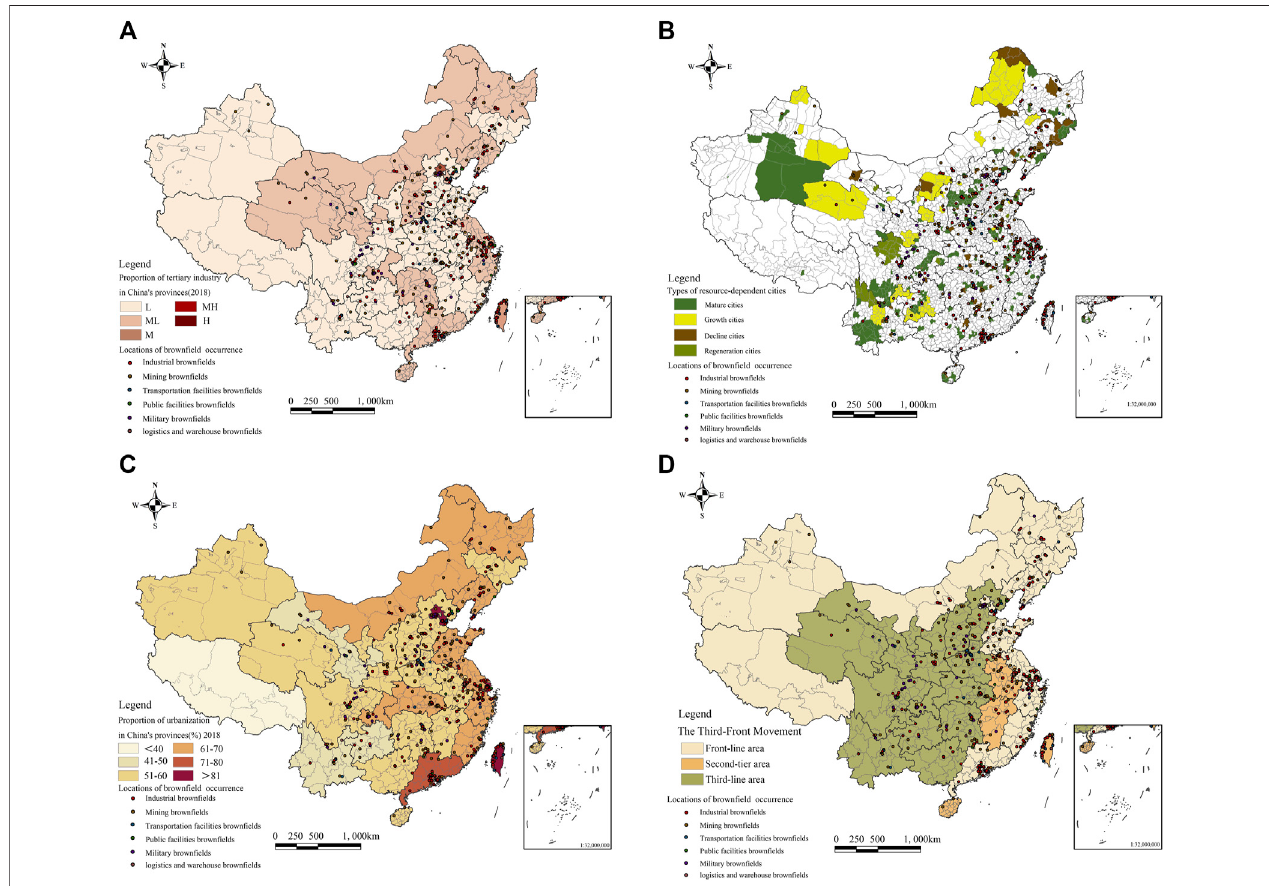
FIGURE4| Brown fi eldrecords indifferentzones. (A) Geo-locationsofbrown fi eldrecordsontheindustrial structure mapofChina. (B) Geo-locations ofbrown fi eld records on the resource-dependent cities map of China. (C) Geo-locations of brown fi eld records on the degree of urbanization map of China. (D) Geo-locations of brown fi eld records on the Third-Front Movement map of